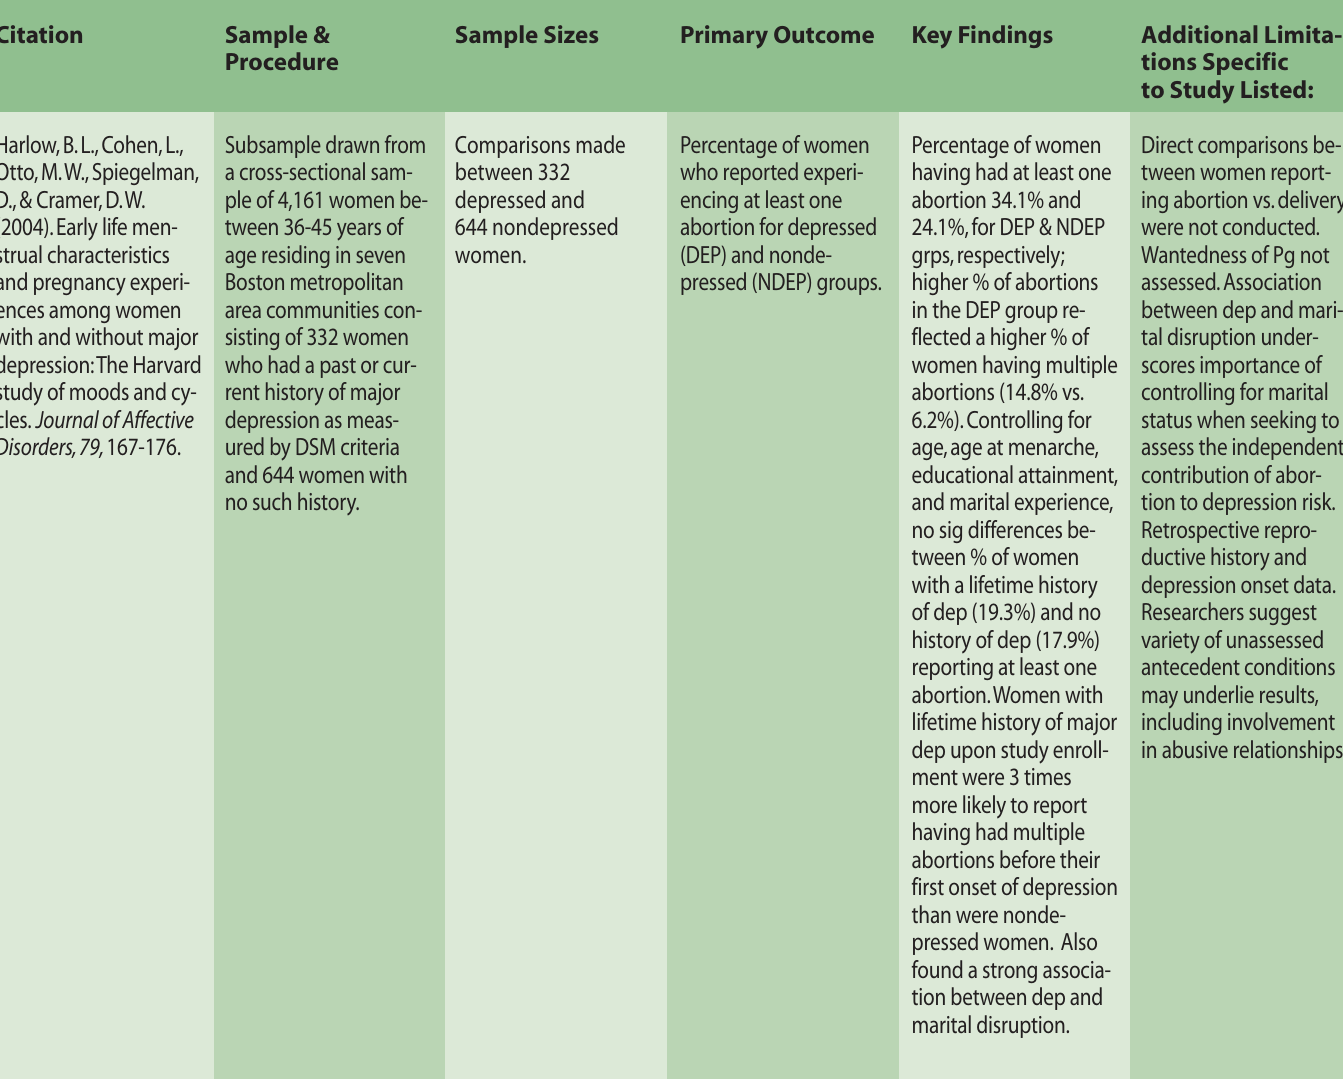
Table 2: Secondary Analyses of Survey Data–Abortion vs.Comparison